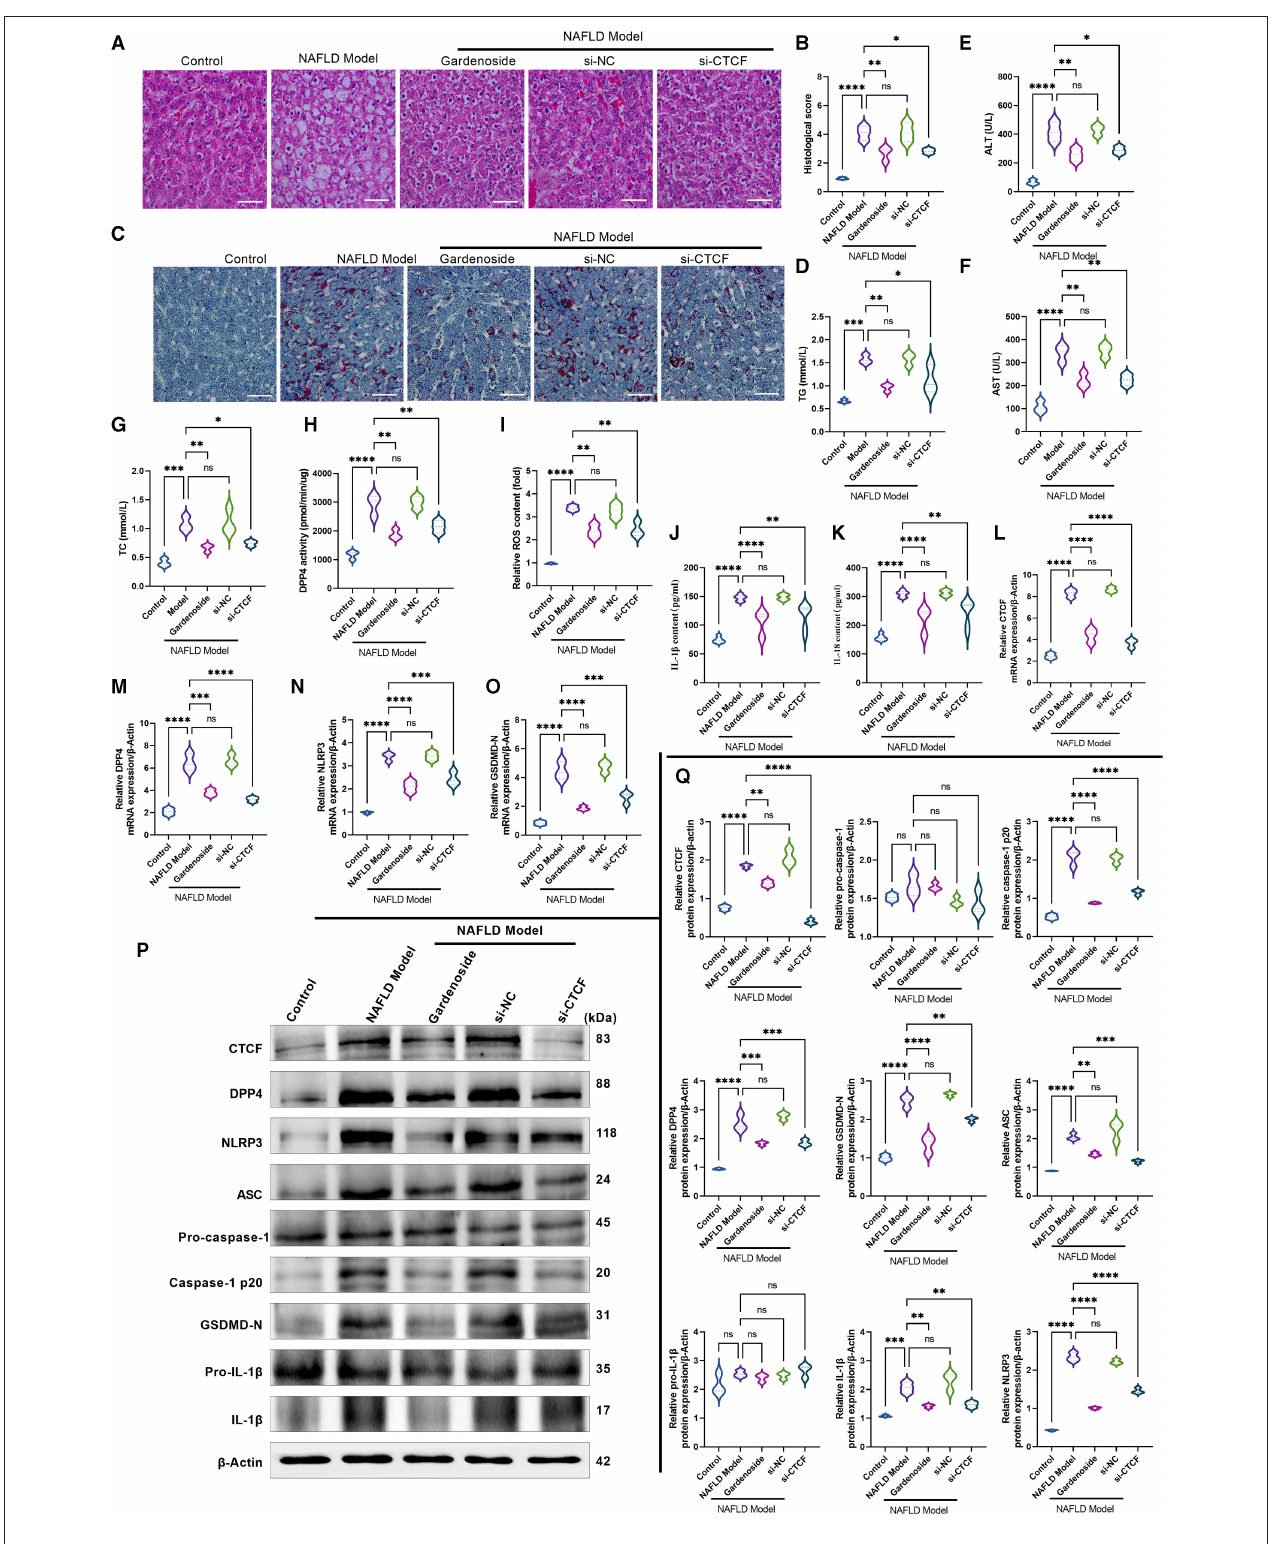
FIGURE 9 | Gardenoside inhibits the lipid accumulation and hepatopathy by the activation of NLRP3 inflammasome and caspase1-induced pyroptosis via the CTCF/DPP4 axis in the NAFLD mice model. (A) HE staining (Scale bar: 100 µ m), (B) histological score, and (C) Oil red O staining (Scale bar: 100 µ m) of liver tissue